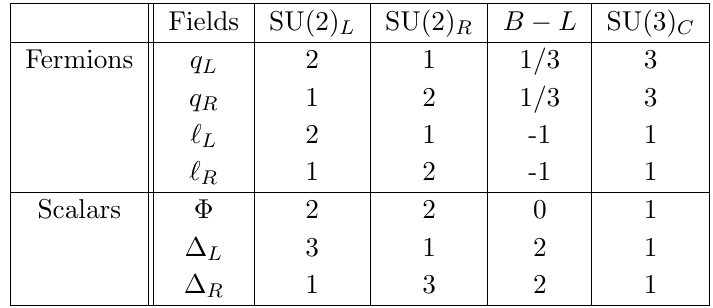
Table 1 . Particle content of the manifest left-right symmetric